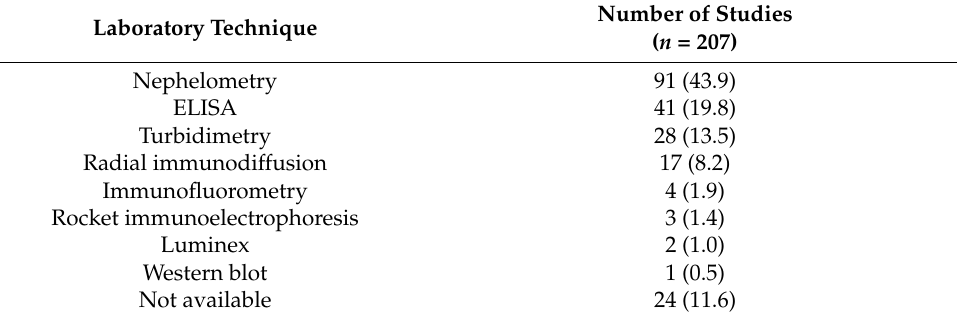
Table 1. Laboratory techniques used in the revised articles.